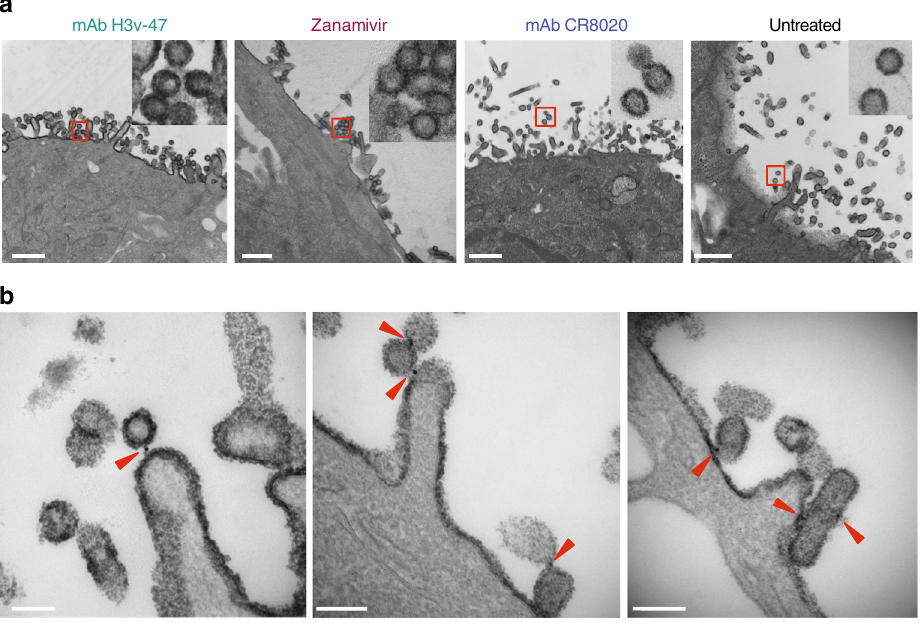
Fig. 5 H3v-47 localizes to interfaces between virus and cell surface or between viral particles. a TEM images of the surface of MDCK cells inoculated with A/Minnesota/11/2010 H3N2v virus and infected cells were incubated with mAb H3v-47, zanamivir, mAb CR8020, or plain Opti-MEM at 3 h postinoculation and fi xed for imaging at 14 h. For each image, the virus particles in the red squares are shown at higher magni fi cation, below. Representative images of two independent experiments are shown. The white scale in each image represents 500 nm. b TEM images are shown of the surface of MDCK cells that were inoculated with virus and subsequently incubated with H3v-47 mAb similar to a , with addition of anti-human IgG conjugated to 10 nm gold particles at 13 h post-inoculation. The black opaque dots indicated by the red triangles represent the gold particles. The white scale in each image represents 100 nm. The experiment was conducted twice